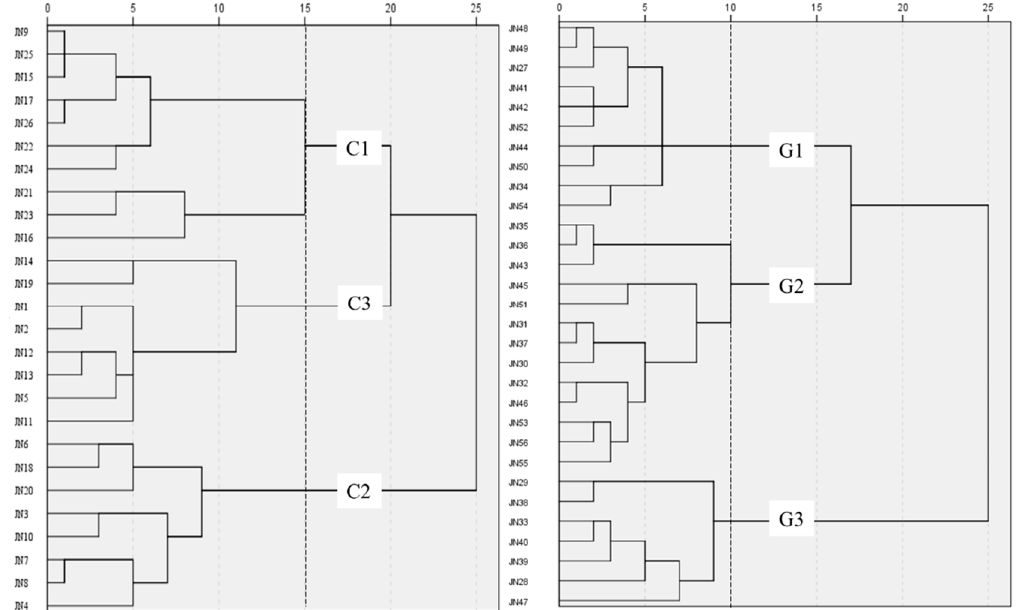
Figure 7. The HCA dendrogram of groundwater samples in May ( left ) and in October ( right ). Table 3. The statistical results of clusters for groundwater samples from May.